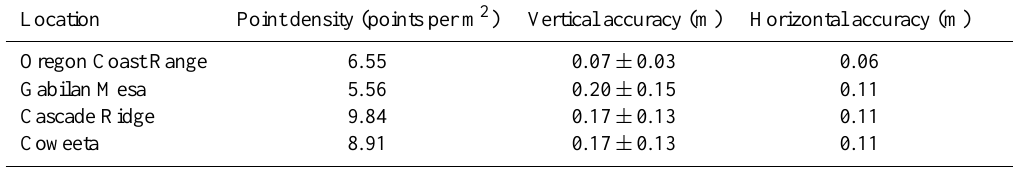
Table A1. Lidar point cloud